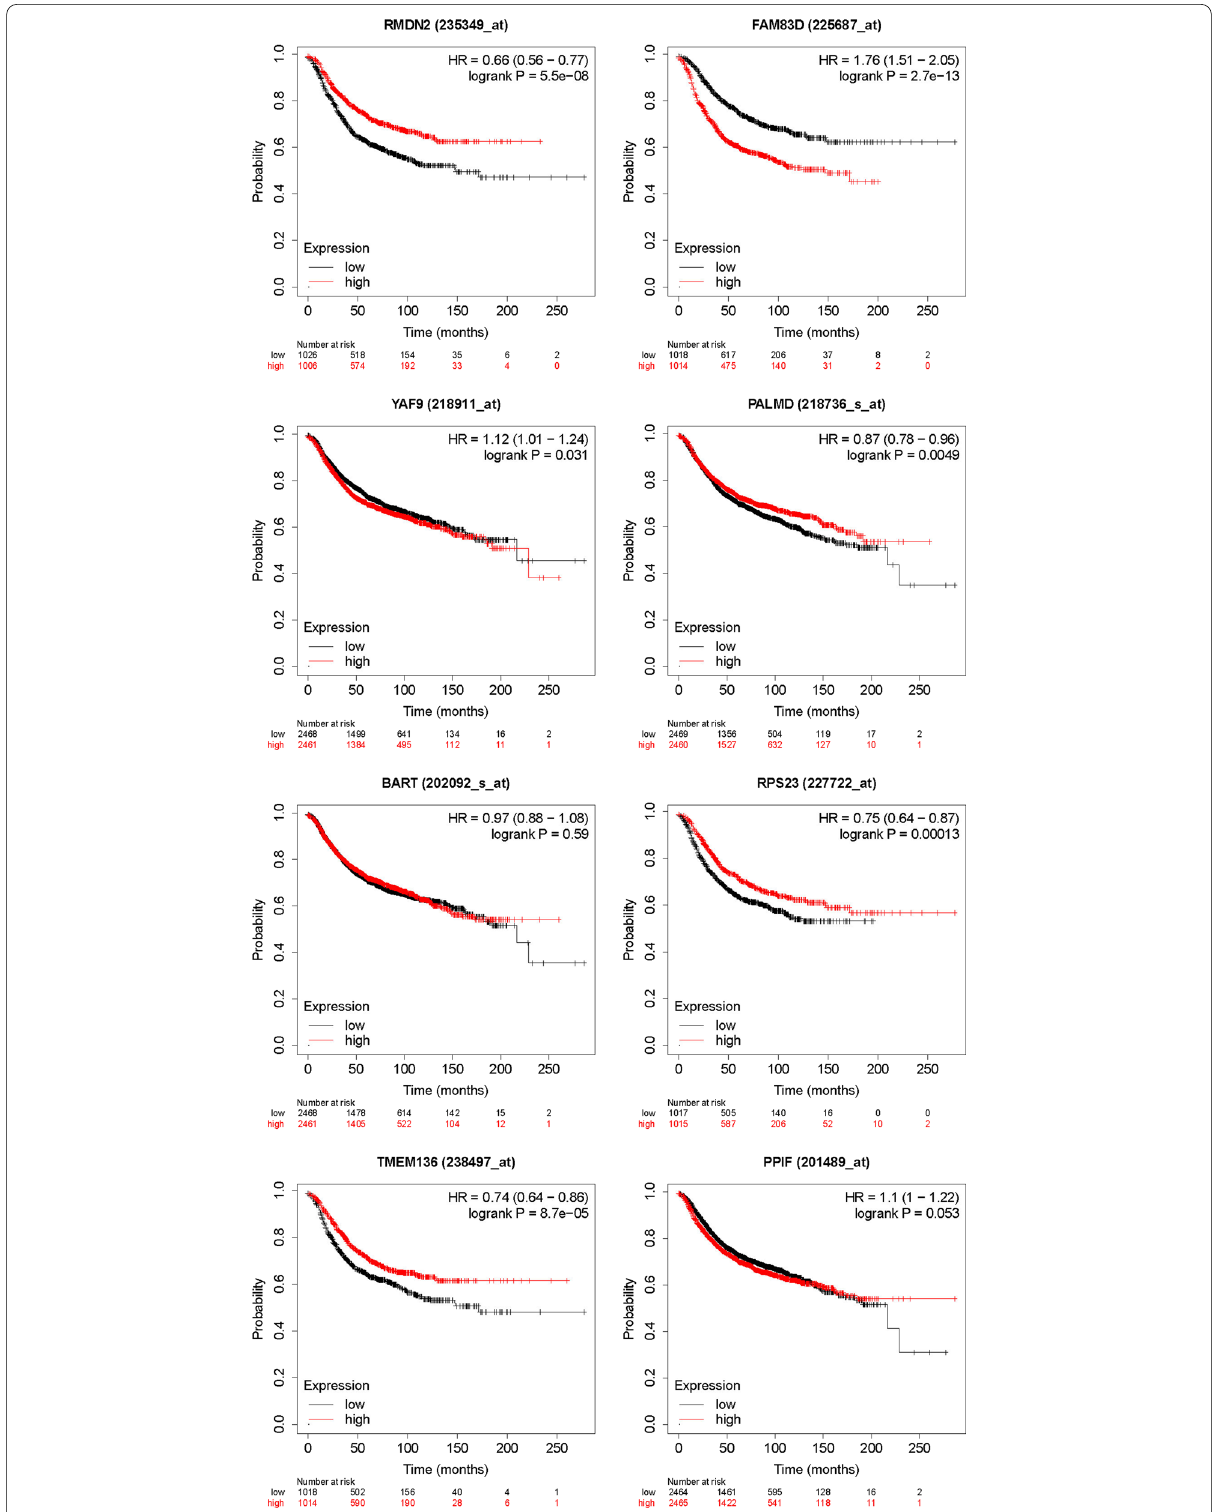
Fig. 8 The KM plot analyese for the identififed genes along with their p-value for relapse free survival rate (note: the other names for the genes are listed as YAF9 (YEATS4), bHLHe38 (MYCL), SERPINA3 (AACT), TMPRSS15 (PRSS7) and no RFS data were available for OR2G2 and C5orf52